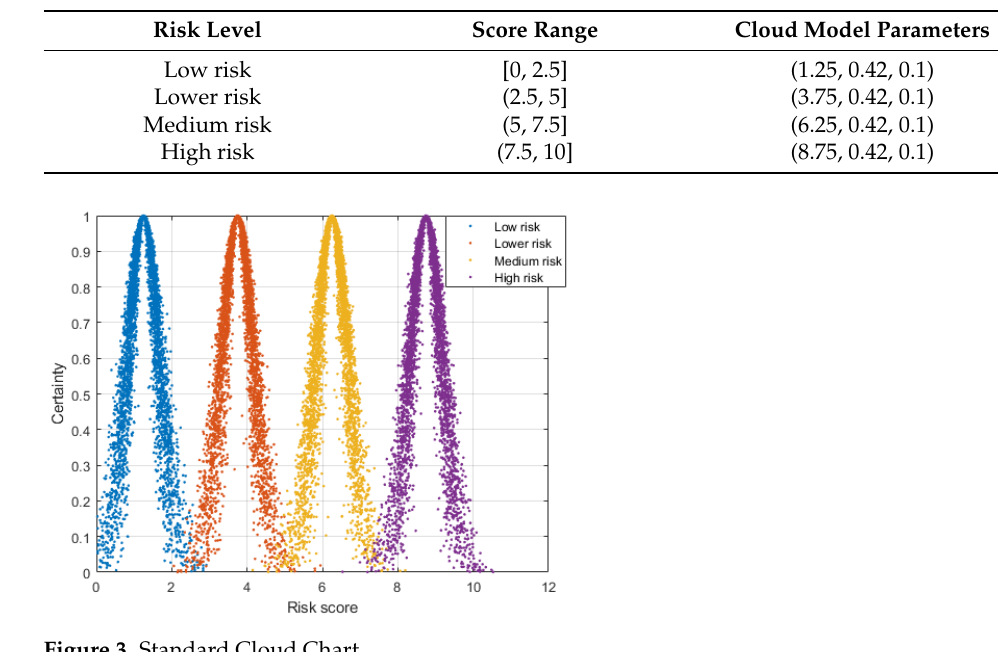
Figure 3. Standard Cloud